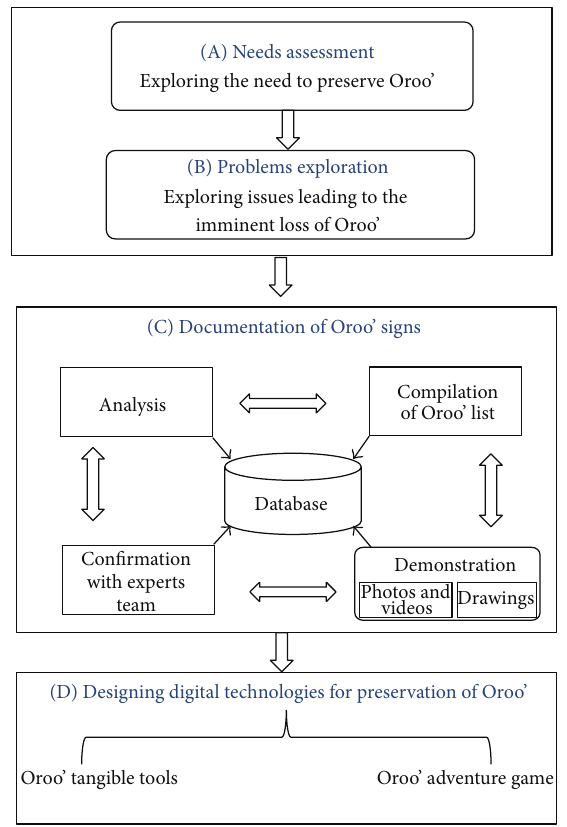
Figure 2: Research process.